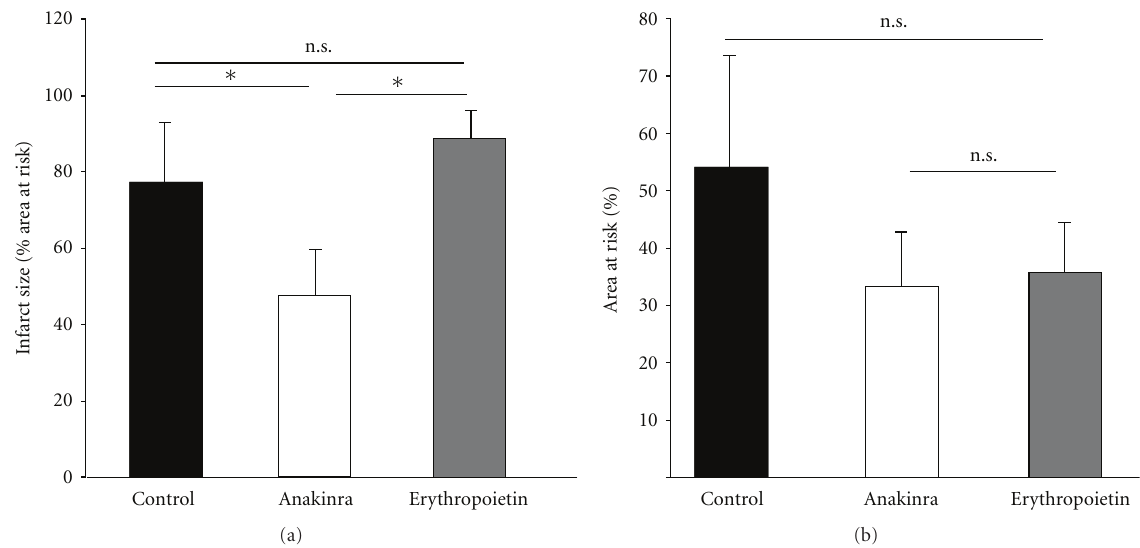
Figure 1: (a) Impact of Anakinra and erythropoietin on infarct size. One-time intravenous administration of Anakinra prior to reperfusion resulted in a significant reduction of infarct size expressed as infarct mass in relation to area at risk mass (%) compared to controls or animals receiving erythropoietin ( ∗ P < 0 . 05, N = 4/group). (b) Impact of Anakinra and erythropoietin on area at risk. One-time intravenous administration of Anakinra or erythropoietin prior to reperfusion did not significantly influence area at risk (n.s. = non significant, N = 4/group).